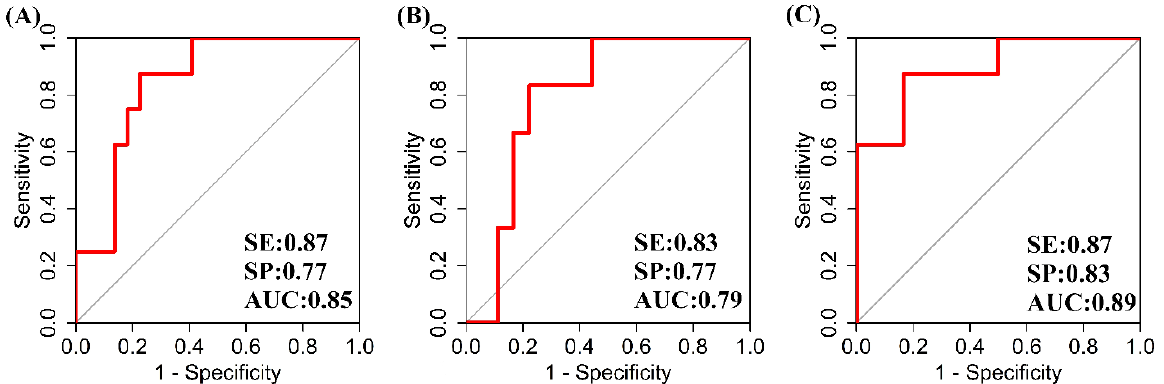
Figure 2. Predictive properties of miR-148b in IgA nephropathy. Figure legend: ( A ): receiver operating